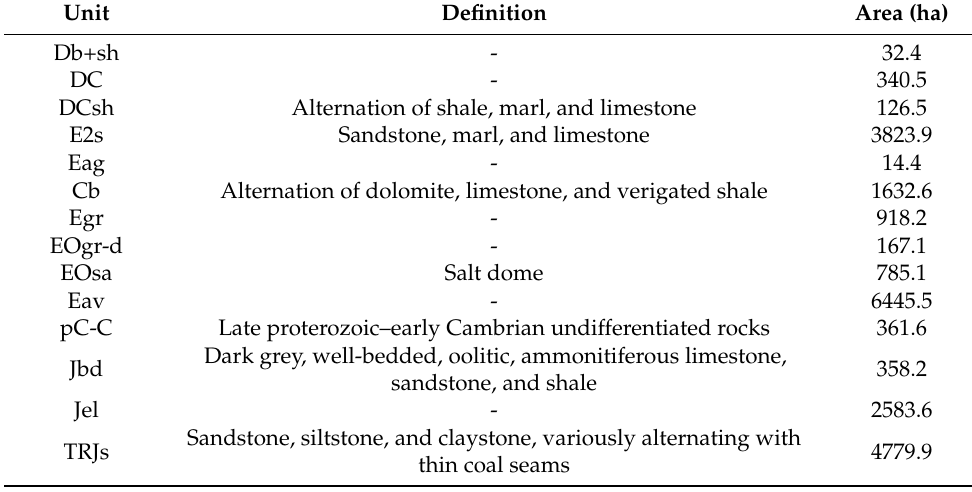
Table A2. Definition of geology map